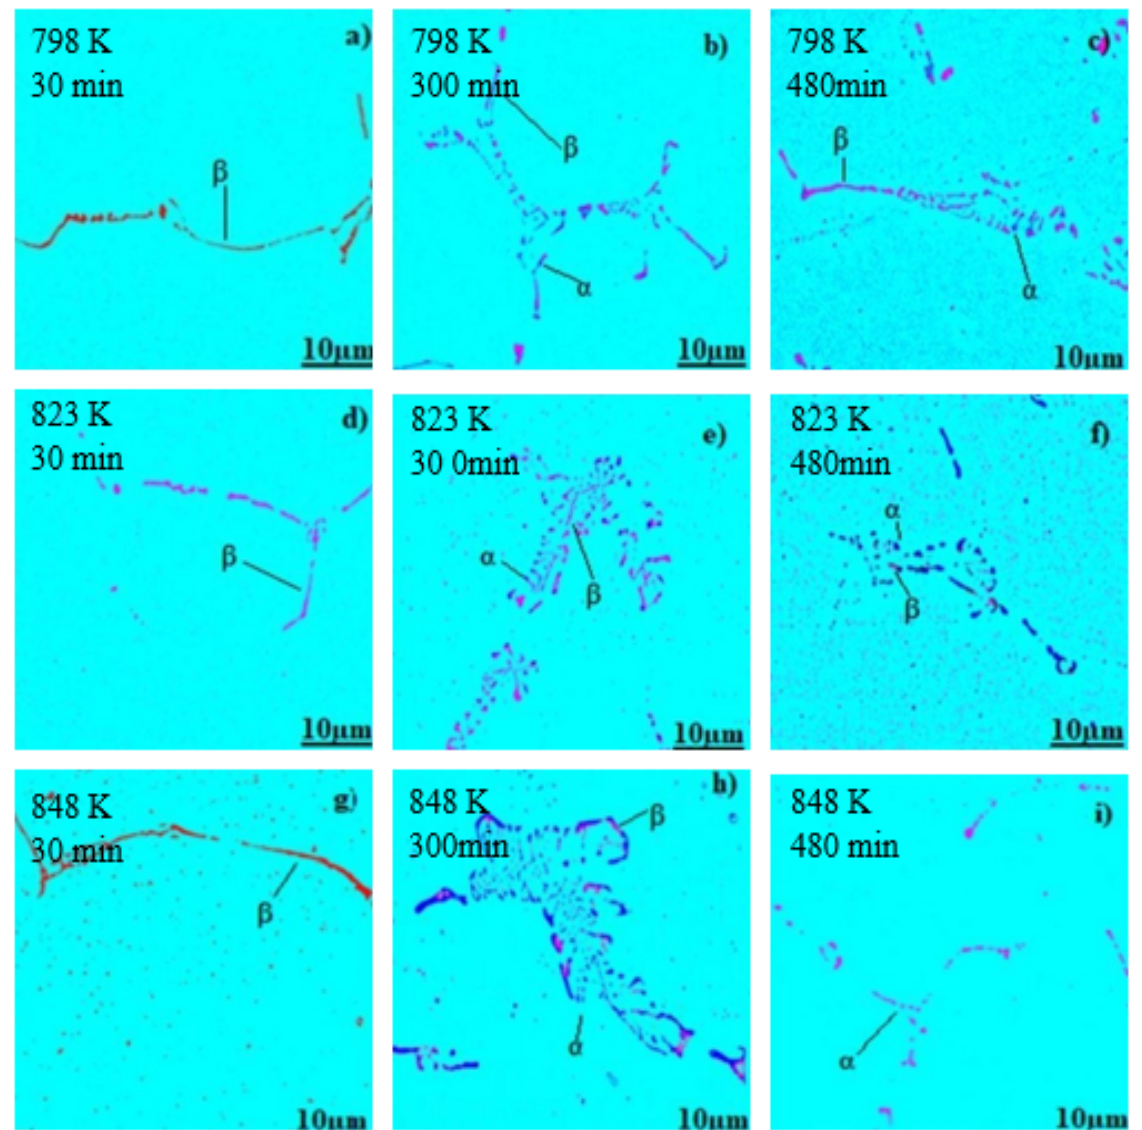
Figure 5. Micrographs of samples heat treated and attacked with Murakami’s reagent, at the indicated temperatures and times (1000×).